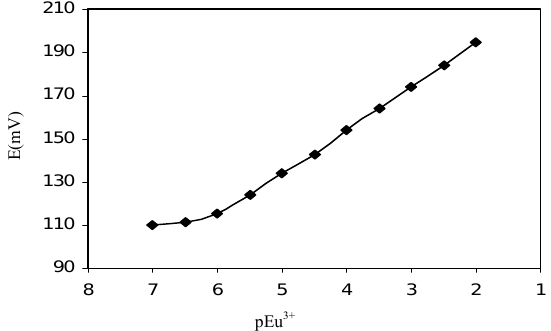
Figure 2. Calibration curve of lutetium electrode based on